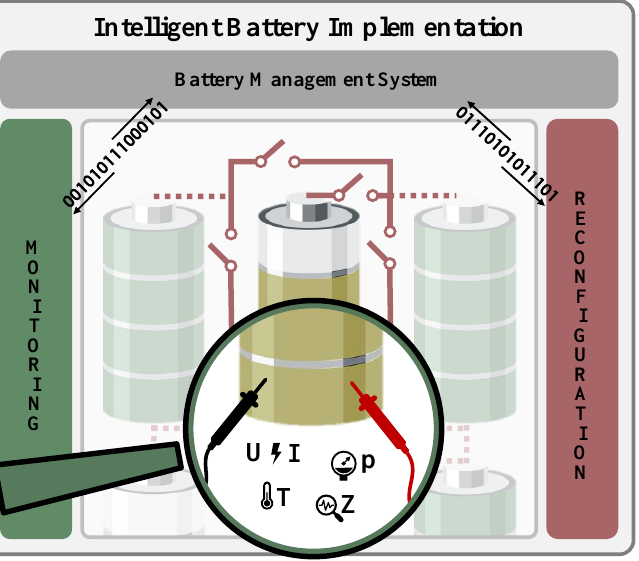
Figure 2. Schematic visualization of the aspects related to the implementation of intelligent battery systems with reconfiguration and advanced monitoring